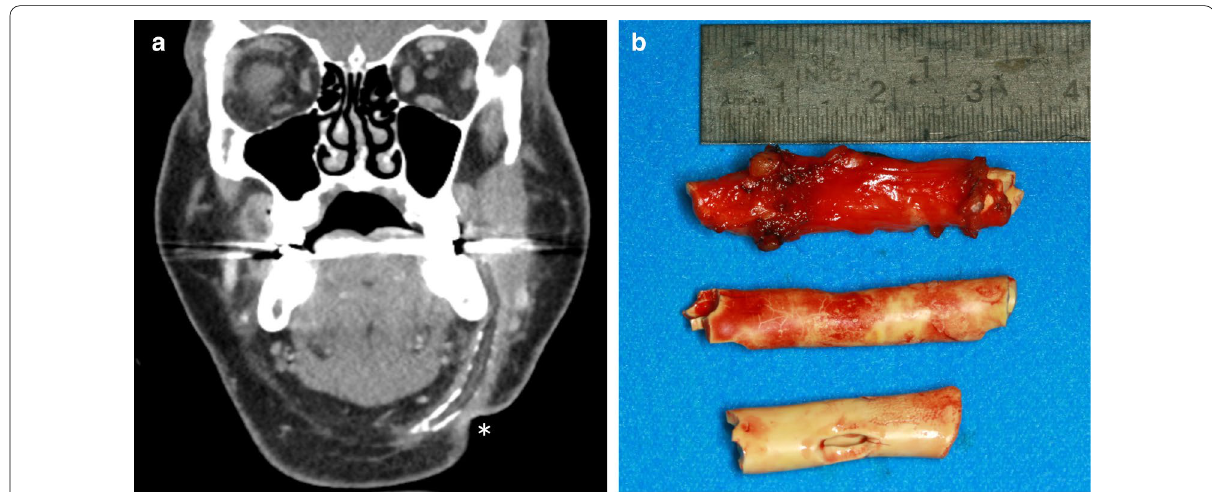
Fig. 13 Plastic drainage tube. Coronal CT image ( a ) showing a tubular hypodense structure with appositional calcifications in the left submandibular space. Adjacent soft tissue reactions raise the suspicion of superinfection. Note the retraction of the soft tissue contour (asterisk), representing the old surgical scar. b Photograph of 3 parts of a drainage tube after